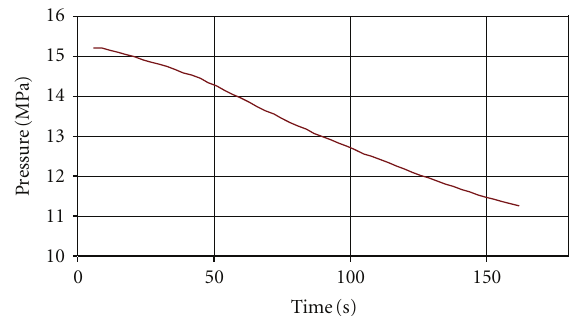
Figure 11: Pressure decrease in the DP test.